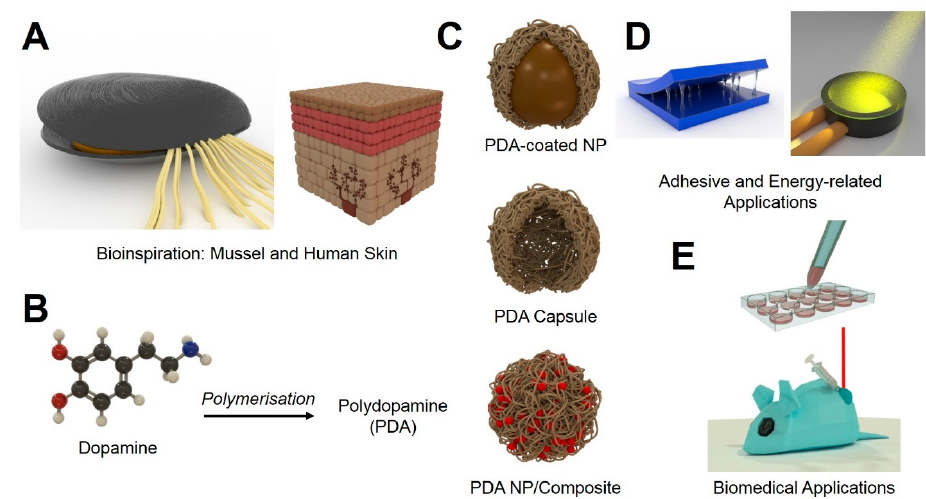
Figure 1. Bioinspiration from mussel and human skin ( A ). Formation of polydopamine (PDA) from polymerisation of dopamine molecule ( B ). Illustration of formation different types of PDA structures, namely, PDA-coated NP, PDA capsule, and PDA NP / composite ( C ), their potential use as adhesive and in energy-related applications ( D ) and biomedical application (i.e., drug delivery and photothermal therapy) ( E ).